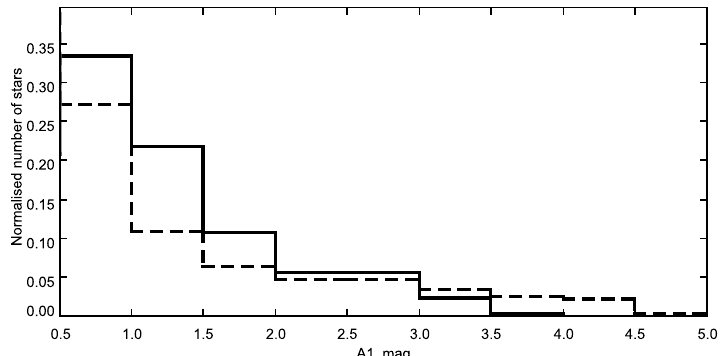
Fig. 5. Catalogued (solid line) and simulated (dashed line) Algols: depth of primary minimum distribution.